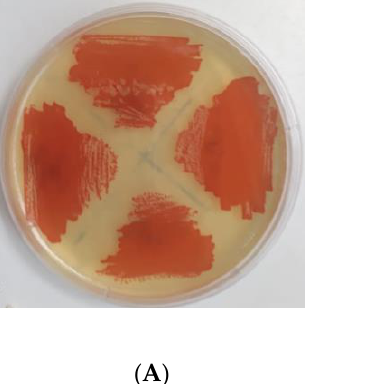
Figure 2. Evolutionary analyses of haloarchaea. The evolutionary history was inferred by using the maximum likelihood method and the general time reversible model (Figure 2) [42]. The percentage of trees in which the associated taxa clustered together is shown next to the branches. Initial trees for the heu- ristic search were obtained automatically by applying the neighbor-join and BioNJ algo- rithms to a matrix of pairwise distances estimated using the maximum composite likeli- hood (MCL) approach, and then selecting the topology with superior log likelihood value. The tree is drawn to scale, with branch lengths measured in the number of substitutions per site. Evolutionary analyses were conducted in MEGA X [24]. The horizontal bar at the base of the figure represents 0.05 substitutions per nucleotide site. The percentage of trees in which the associated taxa clustered together is shown next to the branches, using a bootstrap of 500. The GenBank accessions for the 16S rRNA gene sequences are: MZ576846 (TeSe-89); MZ576847 (TeSe- 86); MZ576848 (TeSe-85); MZ576849 (TeSe-51); MZ576850 (TeSe-41) and MZ576851 (ALT-23). 3.2. Identification of the Carotenoids Compounds Sixteen compounds were identified or tentatively identified by means of high reso- lution Orbitrap mass spectrometry (Table 1, Figures 3 and 4). The fast identification of the